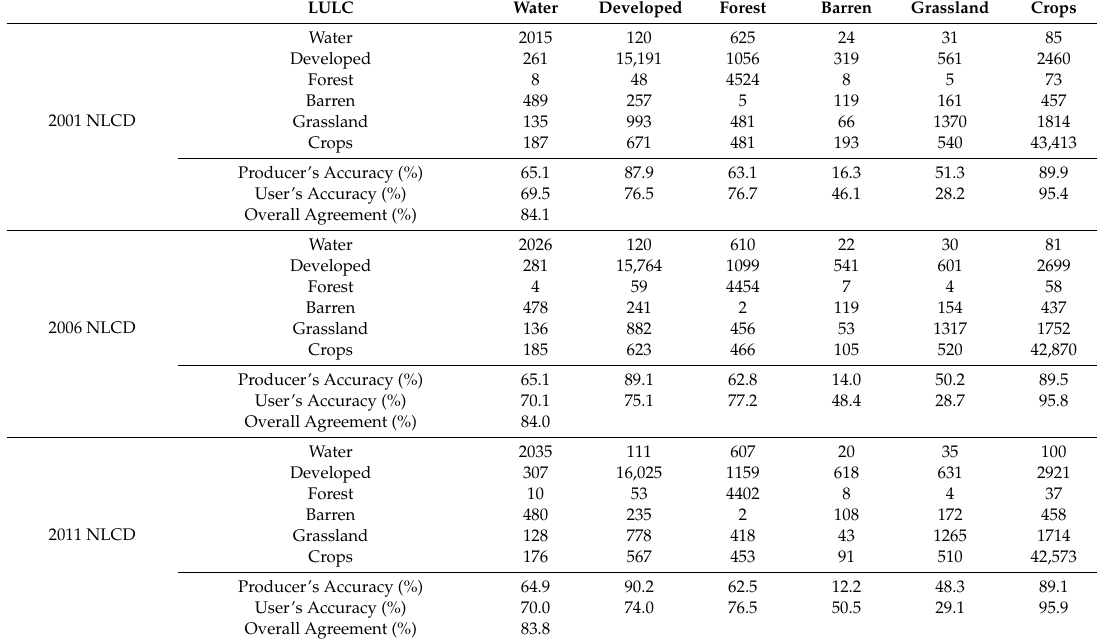
Table 1. Chicago footprint confusion matrix contrasting agreement between the three NLCD validation datasets. Overall agreement was consistently ~84%. Note that units are counts of 30 × 30 m pixels, except Producer’s and User’s Accuracy and Overall Agreement, which are percentages. LULC Water Developed Forest Barren Grassland Crops